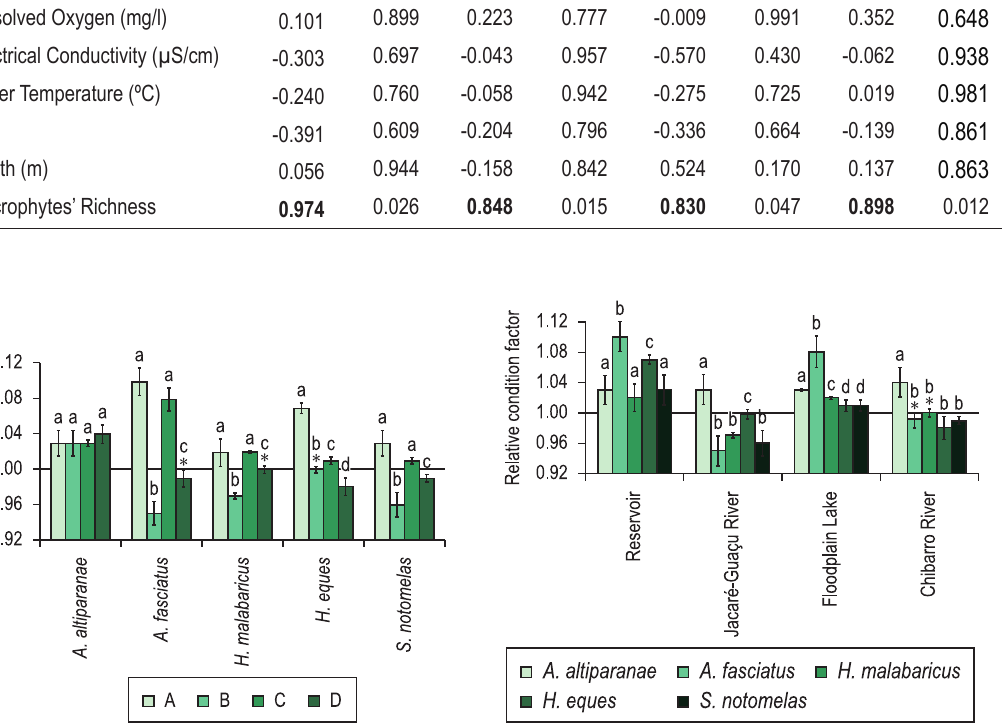
Figure 3. Comparison of the average relative condition factors (with standard error) of the five species, pooling the data of the two periods, in the four habitats: a) The reservoir of Gavião Peixoto Dam; b) Jacaré-Guaçu River; c) floodplain lake; d) Chibarro River. Different letters above bars indicate significant differences among Kn of the species in each habitat ( post hoc Tukey test, P < 0.05), and * indicates no statistical difference from 1 (Student’s t-test, P < 0.05); the gray line indicates the default value (Kn = 1.00).